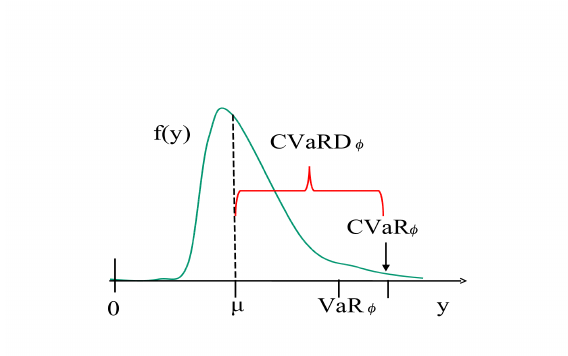
Figure A3. Risk measures associated to a skewed, long tailed generic